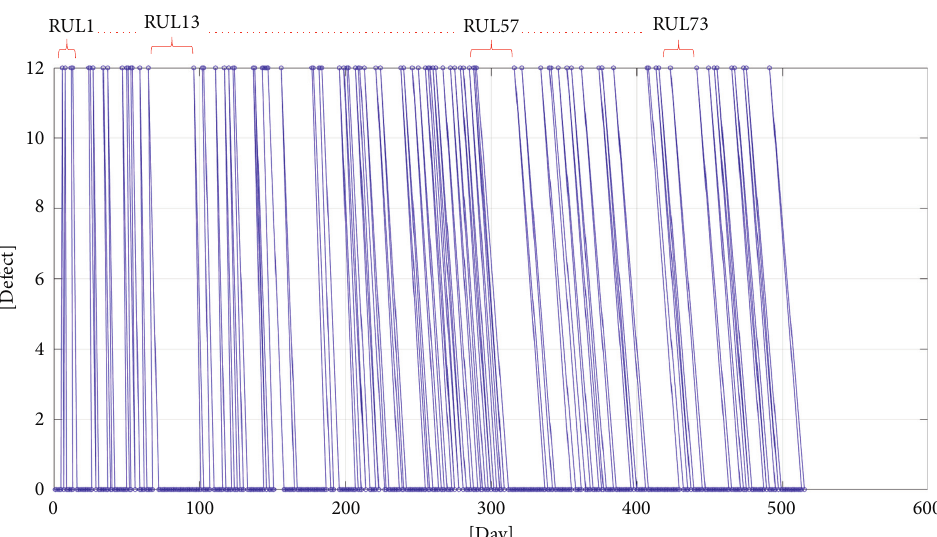
Figure 4: RUL extraction for a specific defect (code no. 442, fault of ECU) from the TCMS “arm”